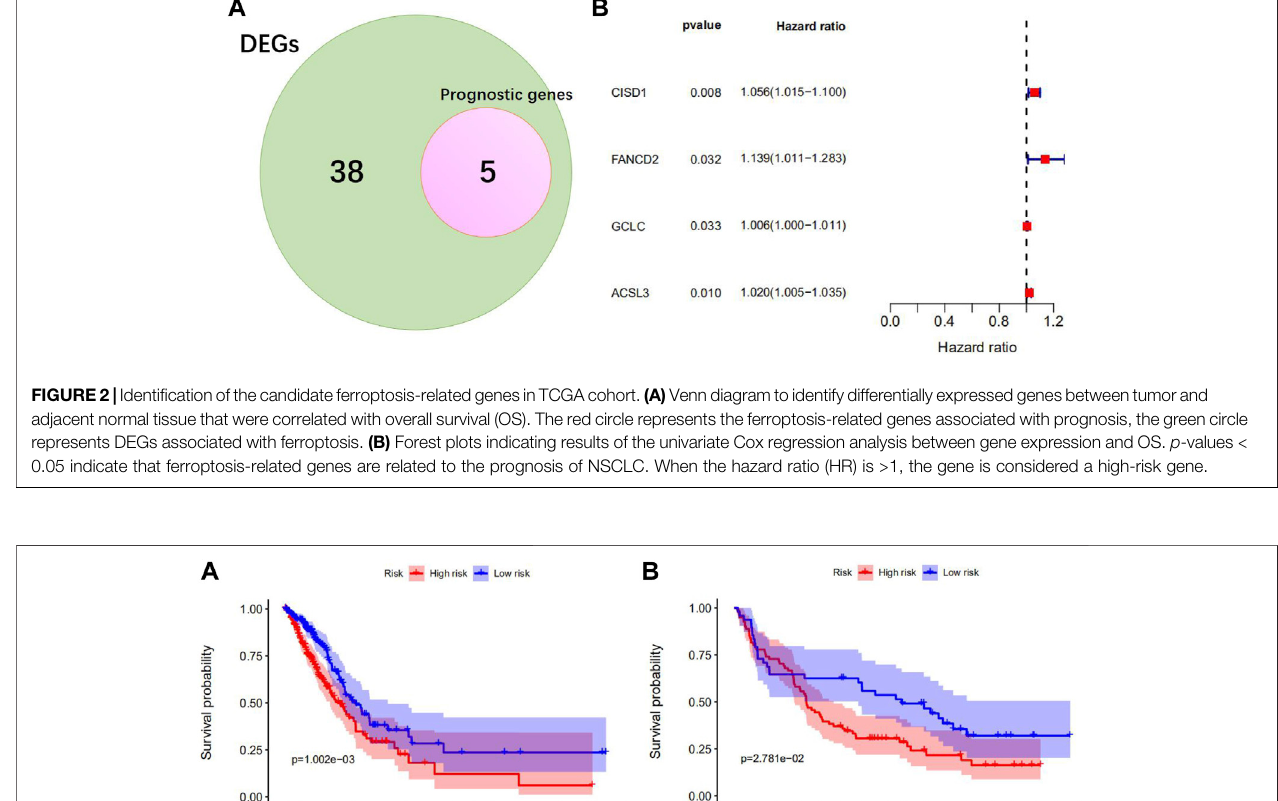
Frontiers in Molecular Biosciences |